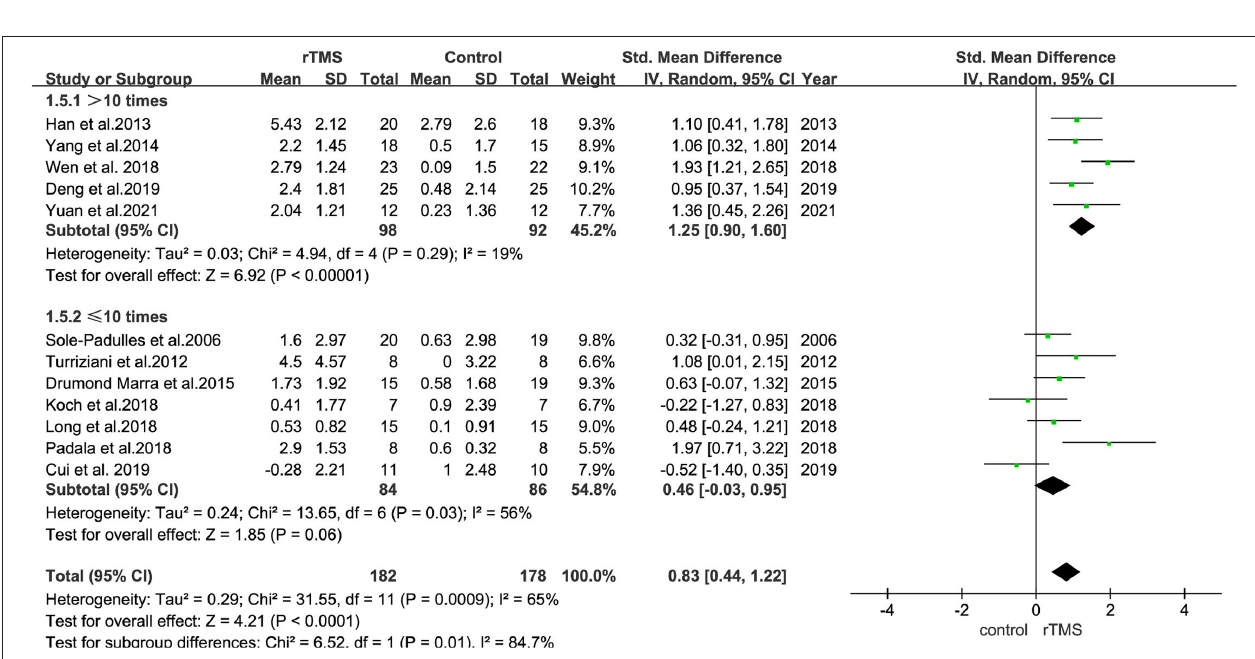
FIGURE 9 | A forest plot showing results of subgroup analyses results for the number of stimulation treatments ( > 10 vs. stimulation numbers subgroup with 95% CI.